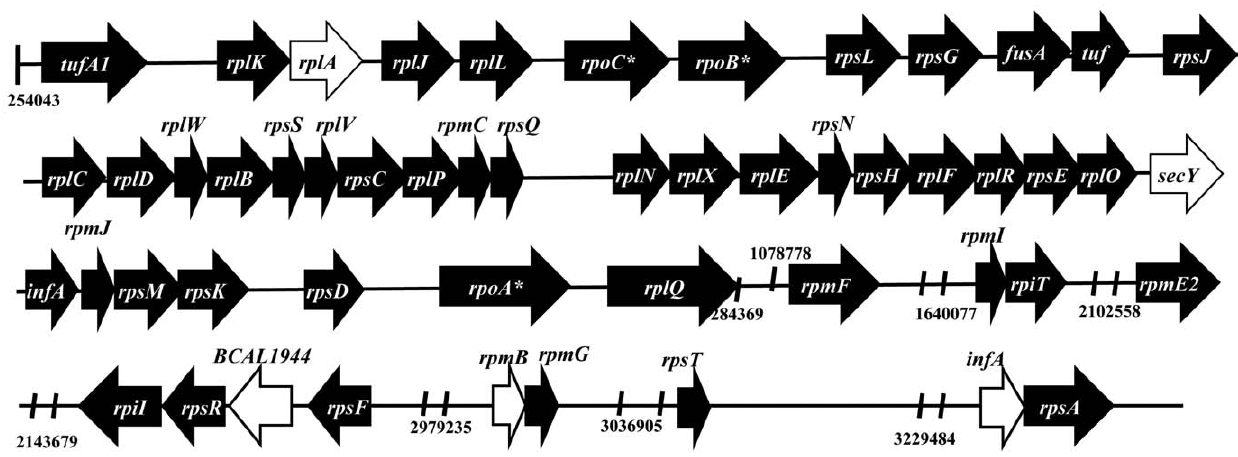
Figure 2. Genetic organization of genes related with translation (ribosomal genes and translation initiation factors) found to be up- regulated in the IST4113 variant, compared to IST439. Black arrows indicate the genes with higher transcript levels in IST4113 than in IST439 whereas white arrows indicate those equally transcribed in the two variants. The localization of the genes in the genome is provided using the genome of the sequenced J2315 as a reference, according with the information available in the Burkholderia Genome Database. Genes marked with an asterisk are not related with translation.